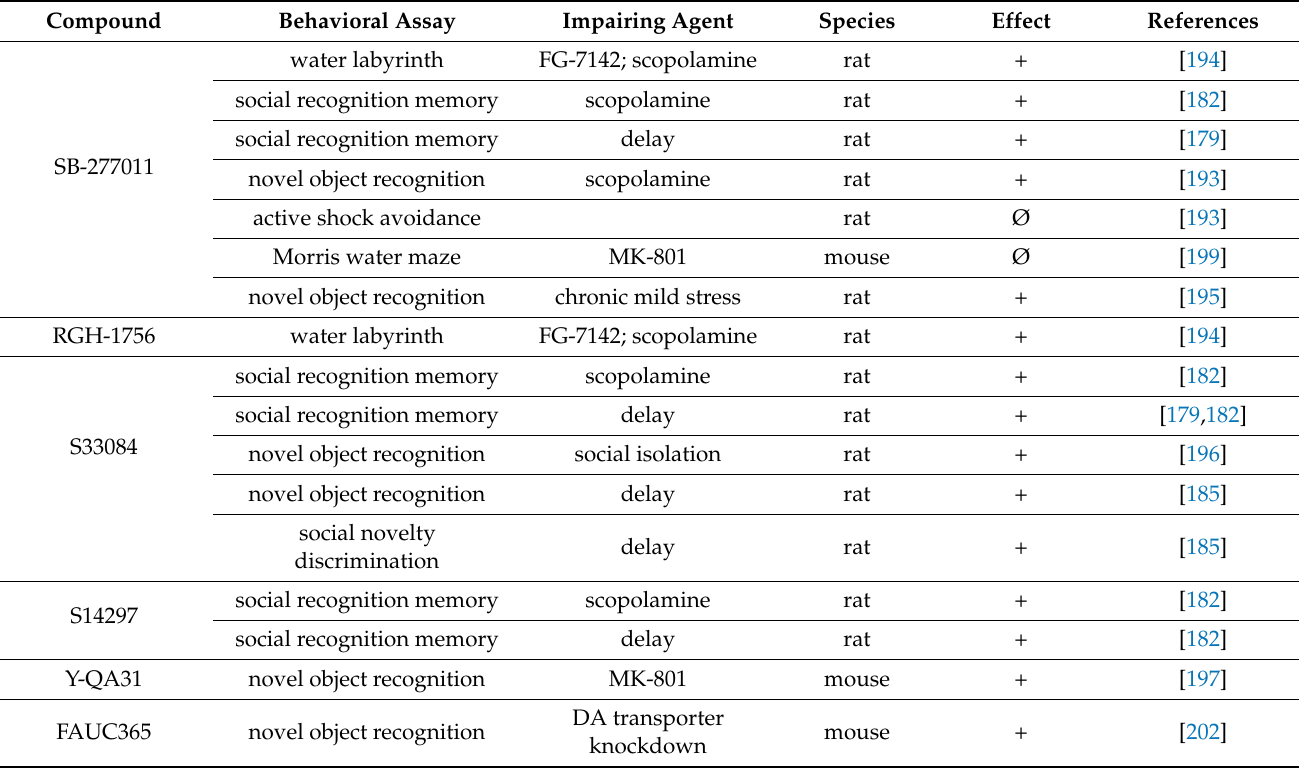
Table 2. Cognitive effects of D3R selective